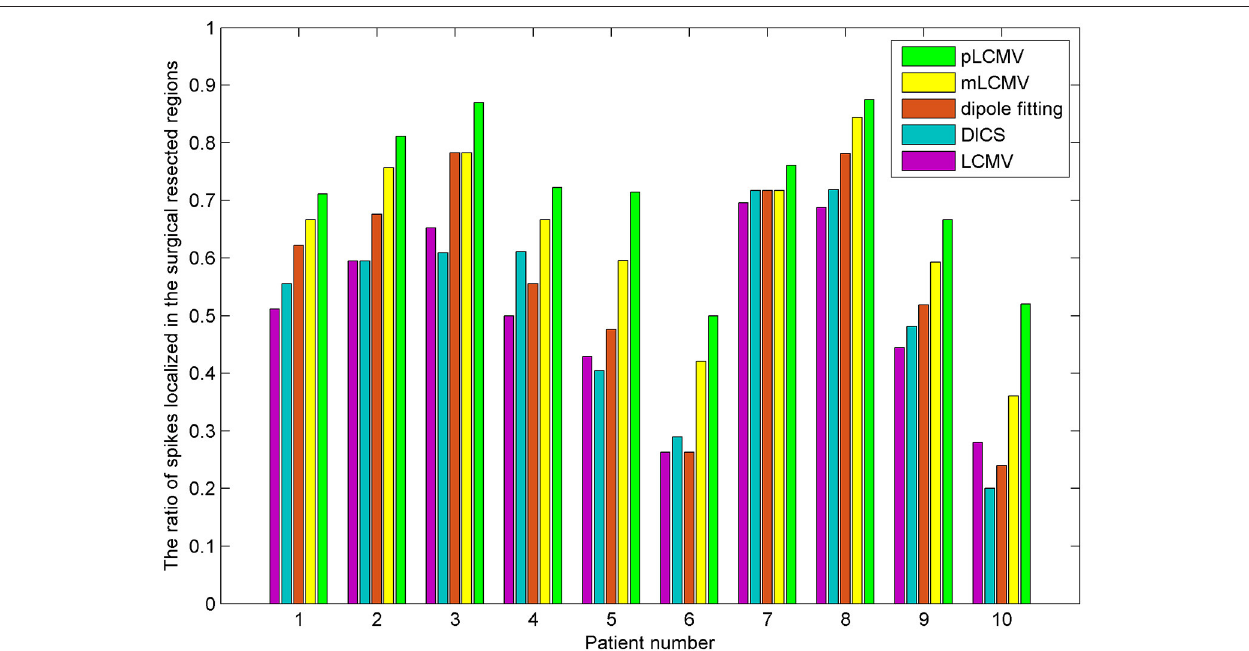
FIGURE 6 | Comparison of localization results obtained for patients with TLE using the proposed method (pLCMV) to those obtained using dipole fitting, LCMV, DICS, and mLCMV methods. The x-axis represents the patient number, and the y-axes represent the ratios of the number of spikes localized in the surgical resected region to the total number of spikes.